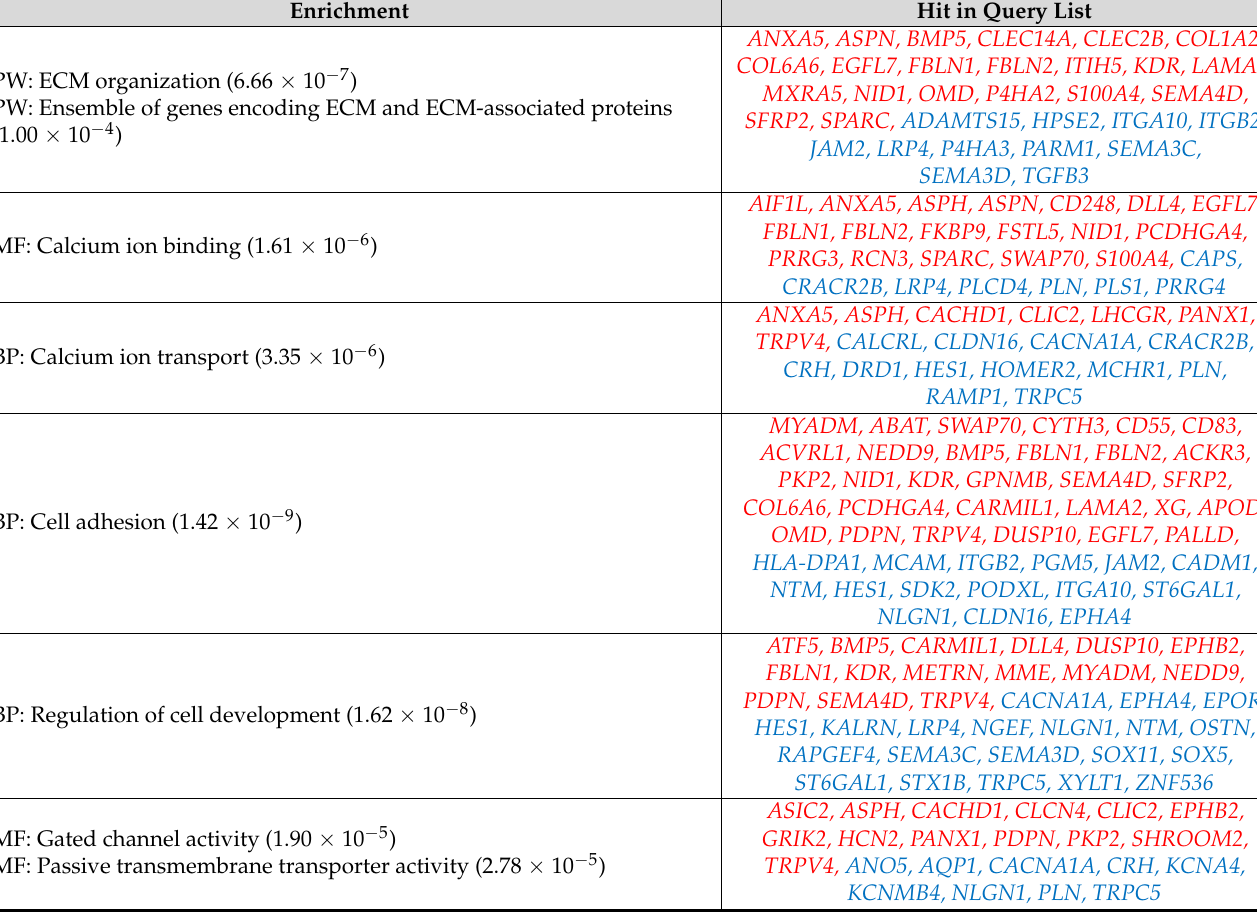
Table 2. Functional enrichment driven by DEGs exclusively deregulated in AA-SScL fibroblasts. The 275 DEGs exclusive to AA-SScL, shown in the blue section of the Venn diagram (Figure 3E), were entered in ToppFun for functional enrichment analysis. Below are pathways (PW) and molecular function (MF) ontologies with the lowest p -value and the most hit genes in the query list. Red: upregulated genes, blue: downregulated genes. Pathways identified by iPathwayGuide’s impact analysis are underlined. The p -values are shown in